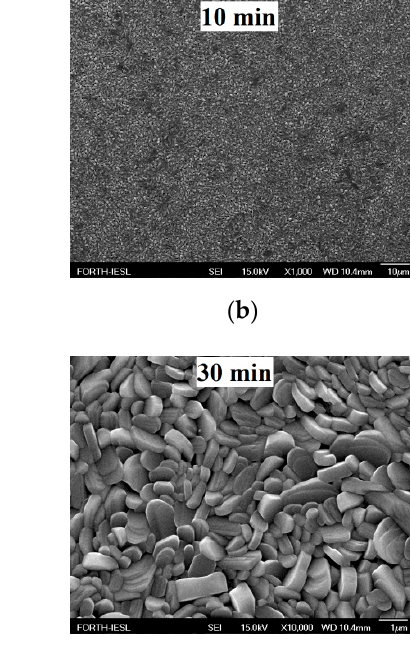
Figure 3. FE-SEM images of V 2 O 5 grown by AACVD at 400 °C for growth periods of ( a ) 5 min, ( b ) 10 min, ( c ) 20 min, and ( d ) 30 min and annealed at 600 °C for 3 h.